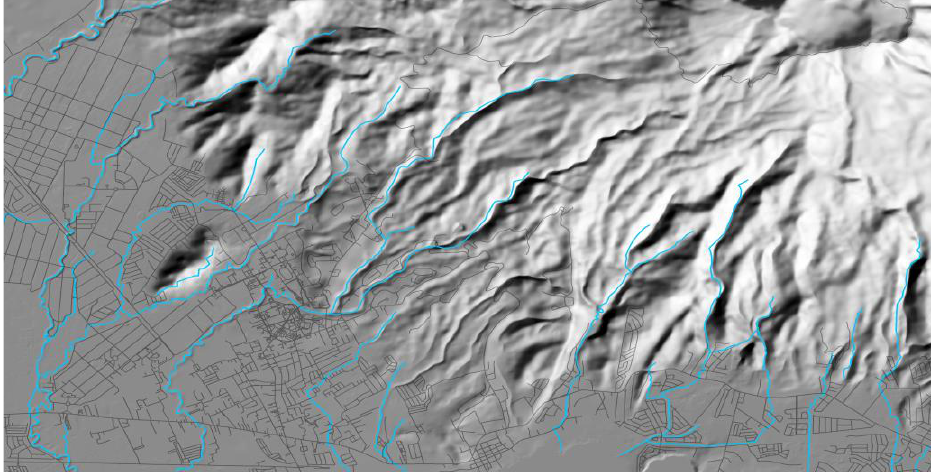
Figure 3. Landscape of the theoretical forest patterned after Mount Makiling Forest Reserve, Philip- pines and used in the GAMA Forest Model.